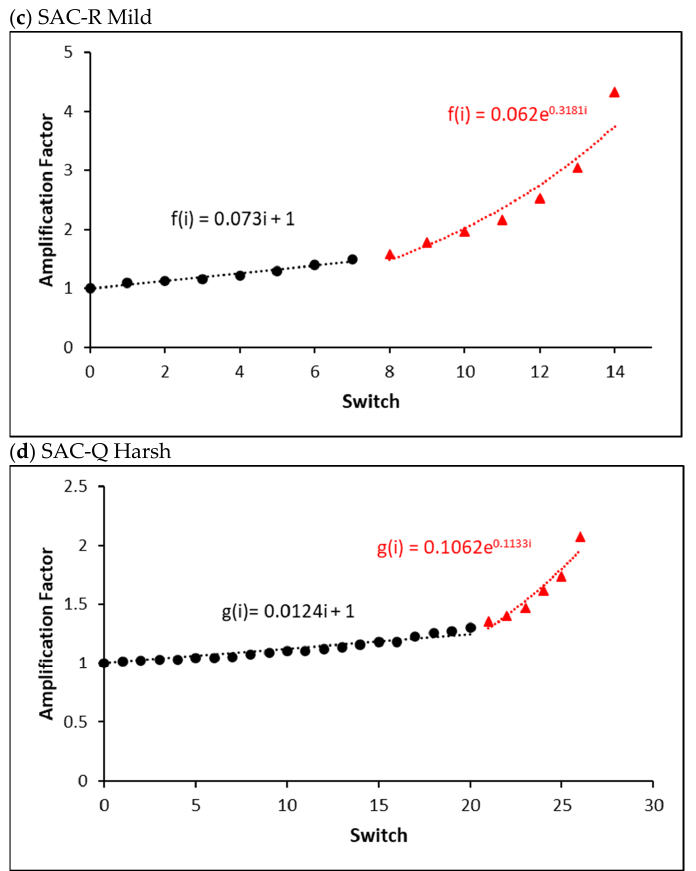
Figure 15. Mild and harsh amplification factor of non-aged ( a ) SAC 305 mild, ( b ) SAC 305 harsh, ( c ) SAC-R mild, and ( d ) SAC-Q harsh individual solder joint in varying stress amplitude test.